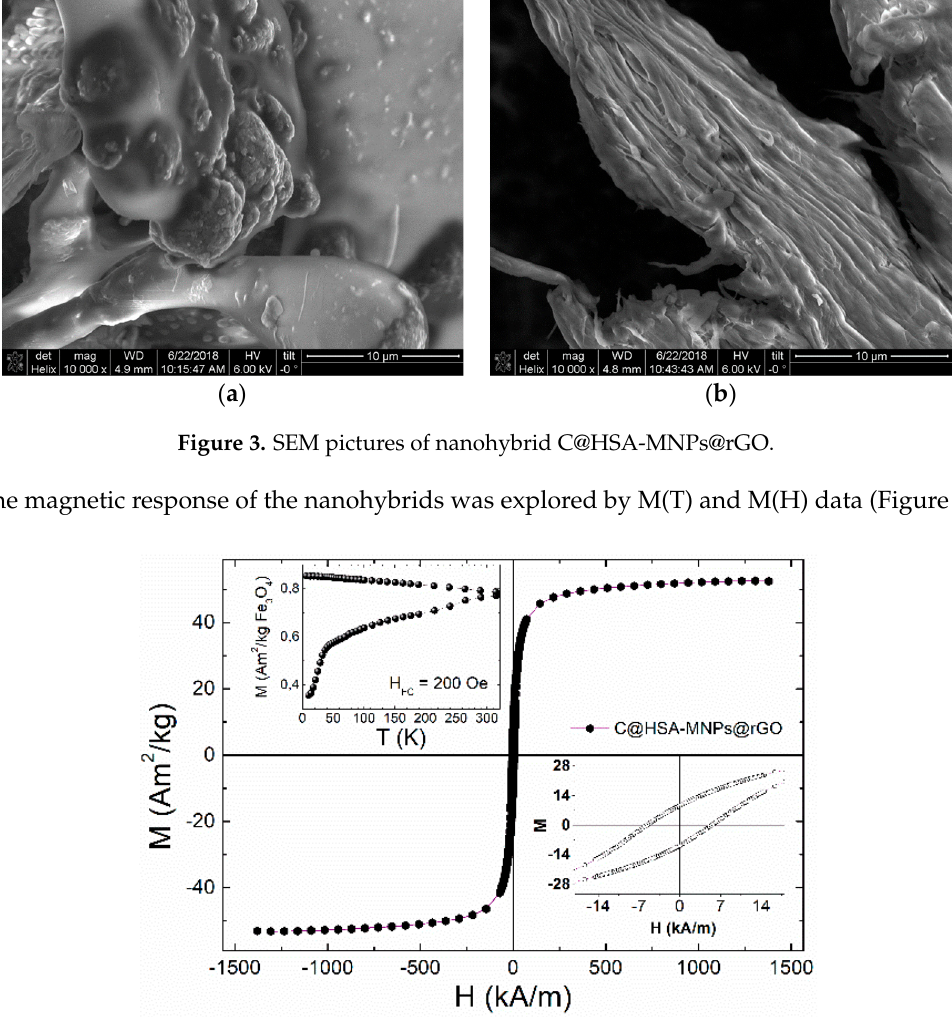
Figure 4. Main panel: Magnetization M data vs. applied field H of nanohybrid C@HSA-MNPs@rGO at room temperature. Upper left panel: Zero-field-cooled and field-cooled M(T) curves at applied field H = 15.92 kA/m. Low-right panel: Magnification of the low-field region of the M(H) hysteresis loop, showing the measurable coercive field at T = 295 K as a reflect of the blocked state of the magnetic nanoparticles within the nanohybrid.